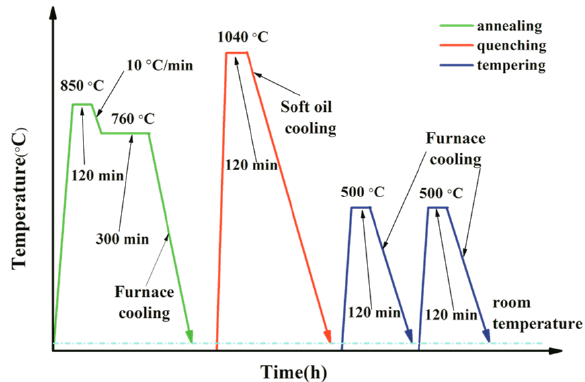
Figure 1. The flow chart of heat treatment process for 5Cr5MoV die steel.